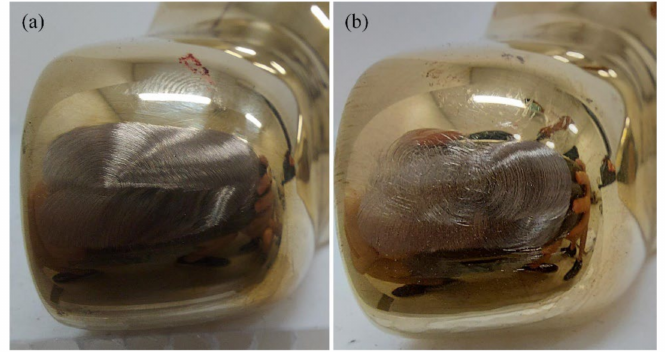
Figure 15. The grinded workpieces using ( a ) the repetitive control and ( b ) no force